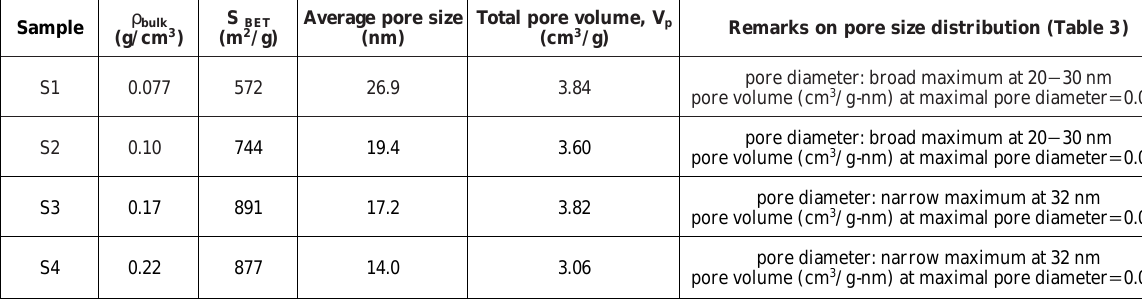
Table 2 Characteristics of silica